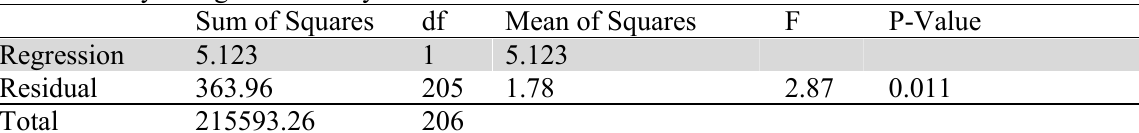
The summary of regression analysis